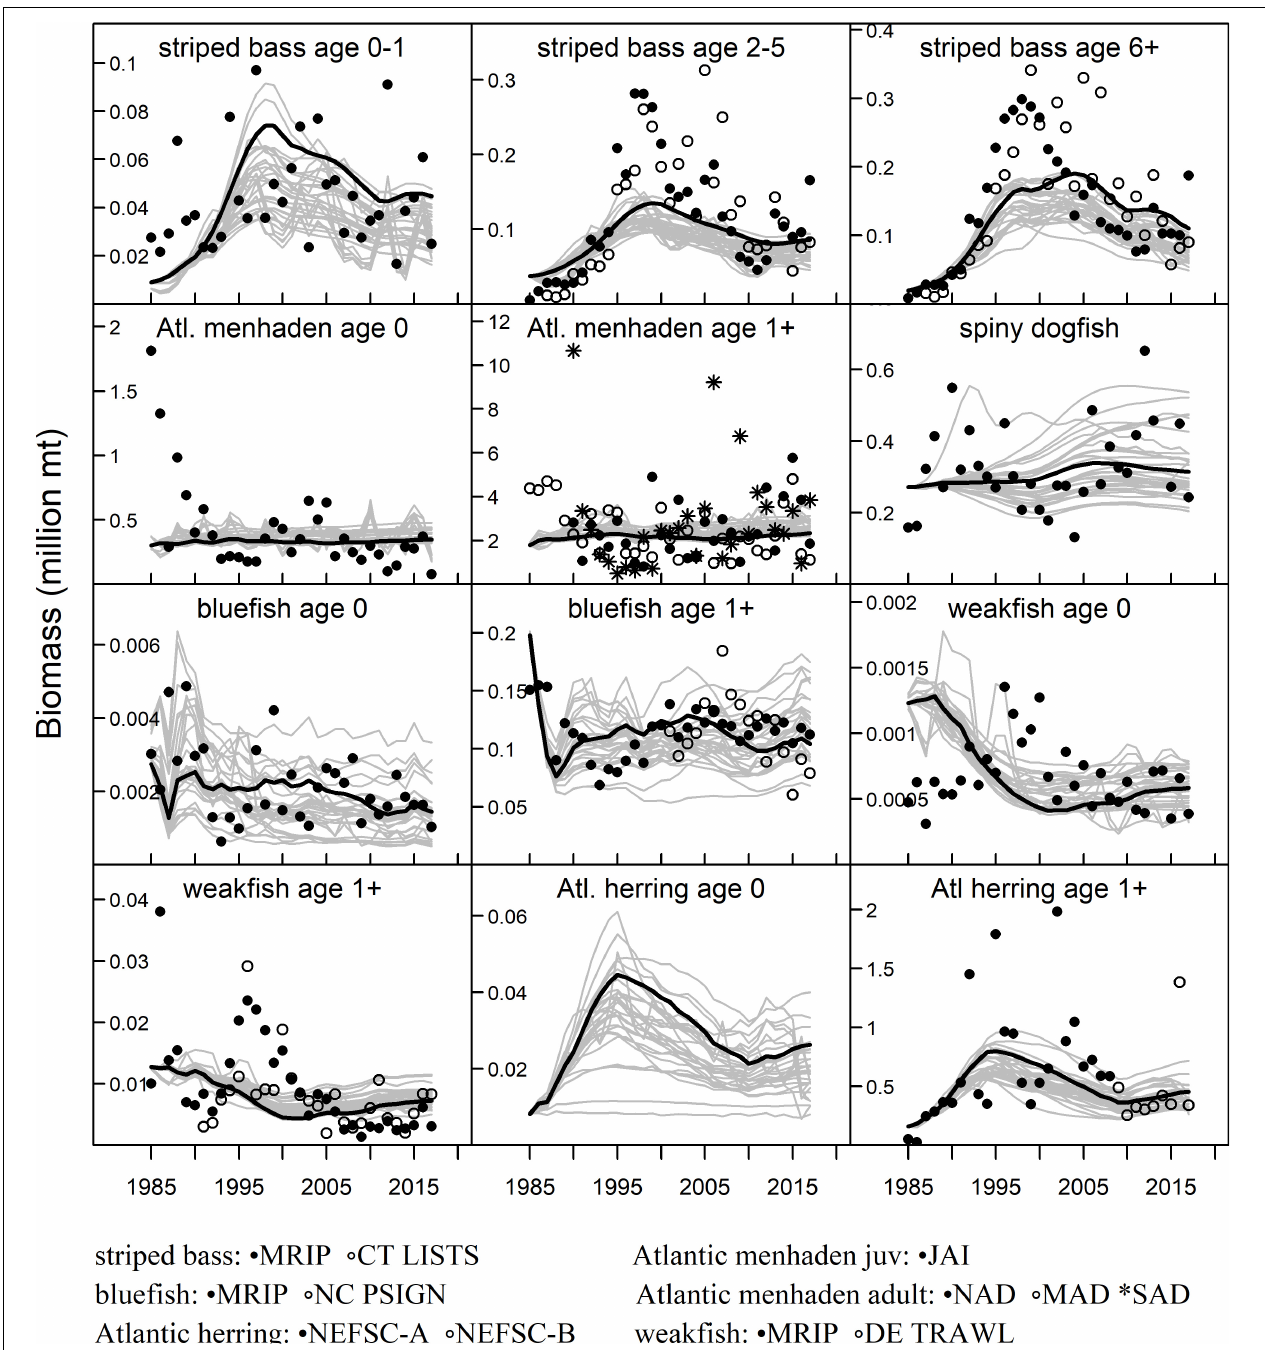
FIGURE 2 | NWACS-MICE Ecosim model fits to relative abundance indices for species in the ERP complex. The solid black line is the base run model (run 8) and the gray lines are the biomass trajectories from all 32 fitted Ecosim models. Observed data are from the Marine Recreational Information Program (MRIP), the Connecticut Long Island Sound Trawl Survey (CT LISTS), the North Carolina Pamlico Sound Inshore Gillnet survey (NC PSIGN), a combined menhaden juvenile abundance index (JAI), combined menhaden adult indices for the northern, mid-Atlantic, and southern regions (NAD, MAD, SAD), the Northeast Fisheries Science Center trawl survey (NEFSC, 2 time periods), and the Delaware Sound Trawl Survey (DE TRAWL).